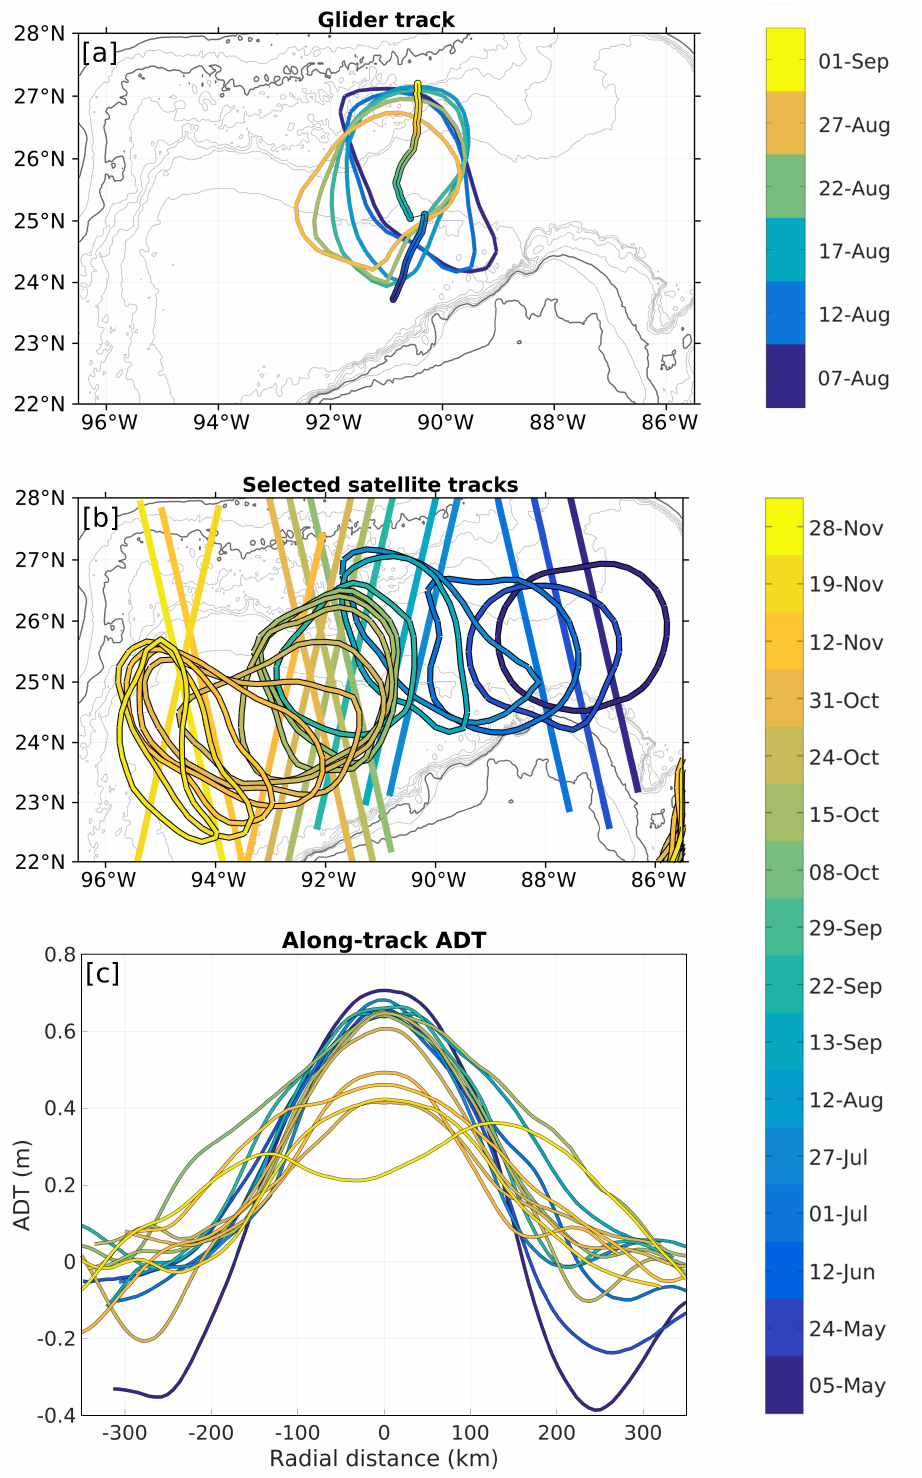
Figure 2. ( a ) Map of the glider survey superimposed on successive edge contours of the ring between 07/08/2016 and 01/09/2016. The edge contour is estimated using Absolute Dynamic Topography. Time is color-coded. ( b ) Selected satellite tracks superimposed on the ring’s edge contour on the same day. Time is color-coded. ( c ) Along-track Absolute Dynamic Topography (ADT) profiles for the 15 cross-eddy satellite tracks shown on panel ( b